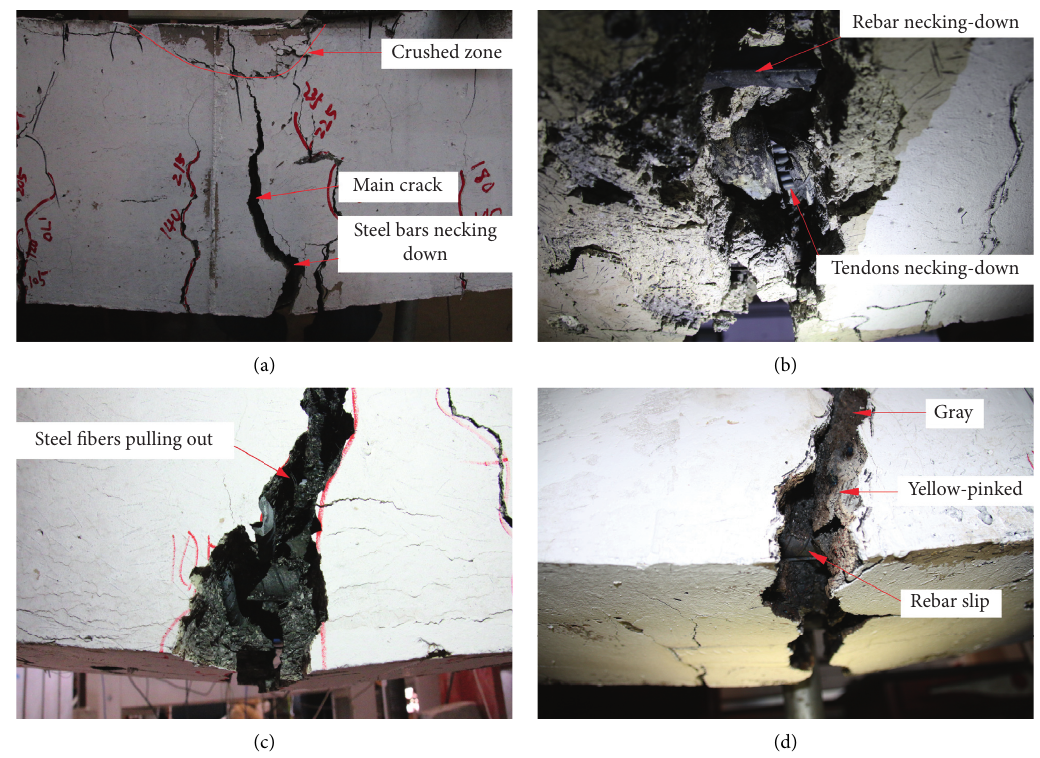
Figure 13: The failure mode of specimens. (a) Main crack. (b) Steel bar yield. (c) Steel fiber pulling out. (d) Rebar